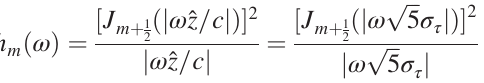
ffiffiffi p 5 c σ τ for parabolic line